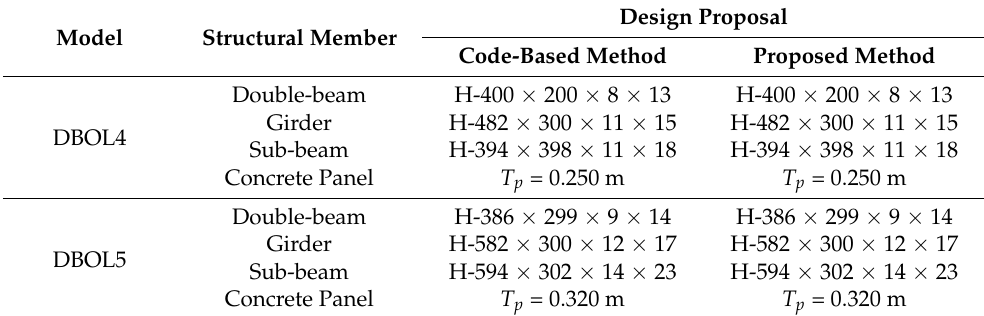
Table 3. Optimal design proposal derived from code-based and proposed methods for the steel double-beam floor systems.